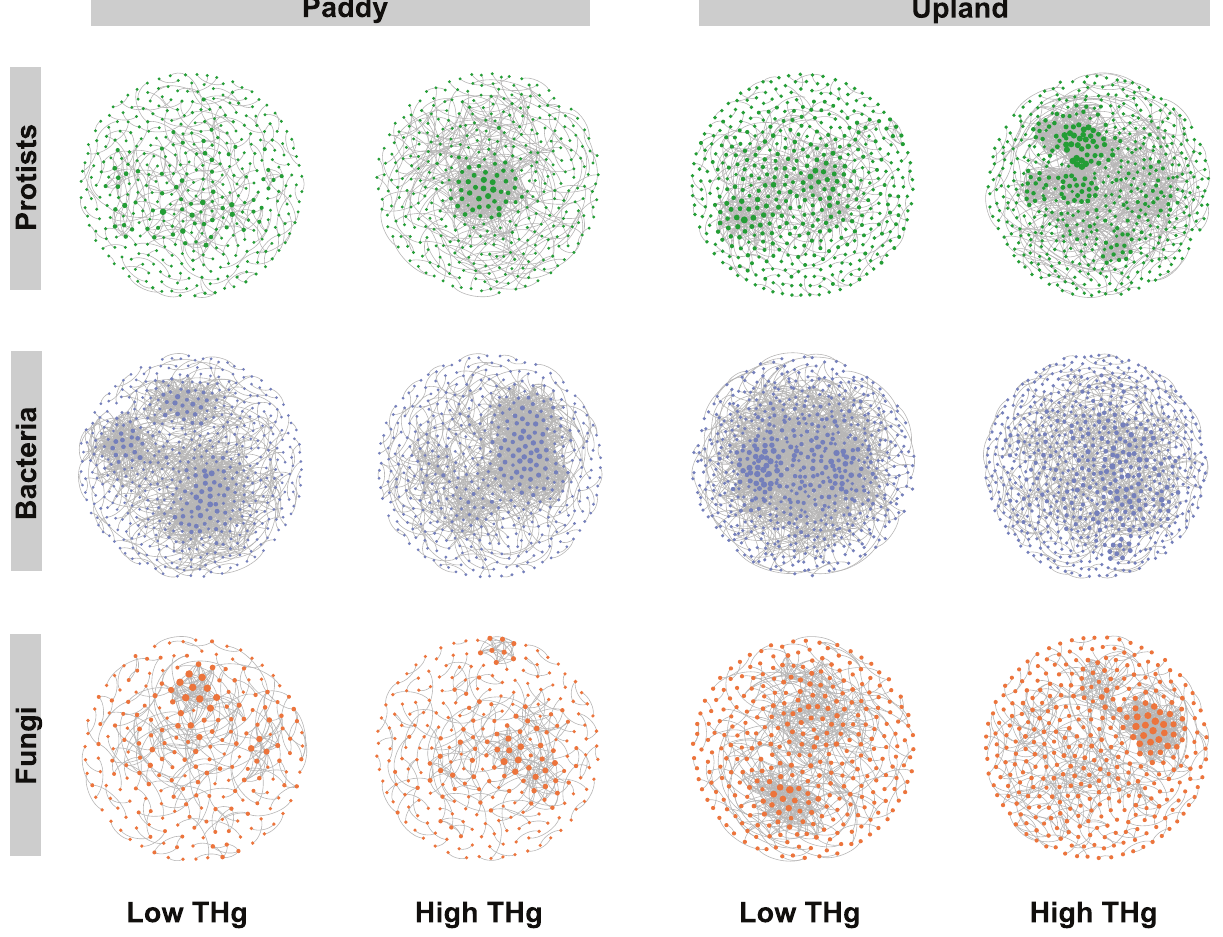
Fig. 3 The intra-kingdom networks visualizing Hg pollution effects on the interactions within soil communities. Node colors represent the taxa of protists, bacteria, and fungi in green, blue, and red, respectively. Node size is proportional to the degree, with a larger node having a higher